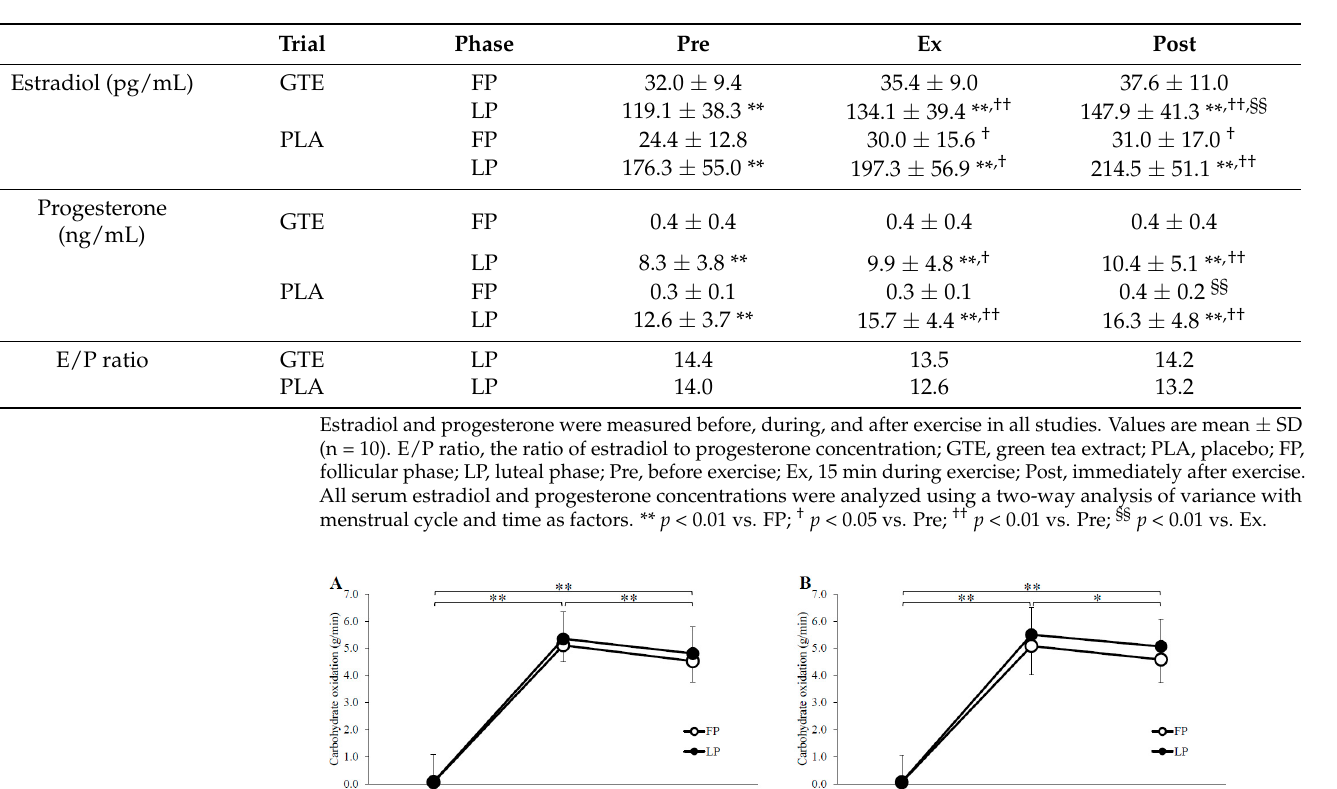
Table 1. Ovarian hormone concentrations before, during, and after exercise.